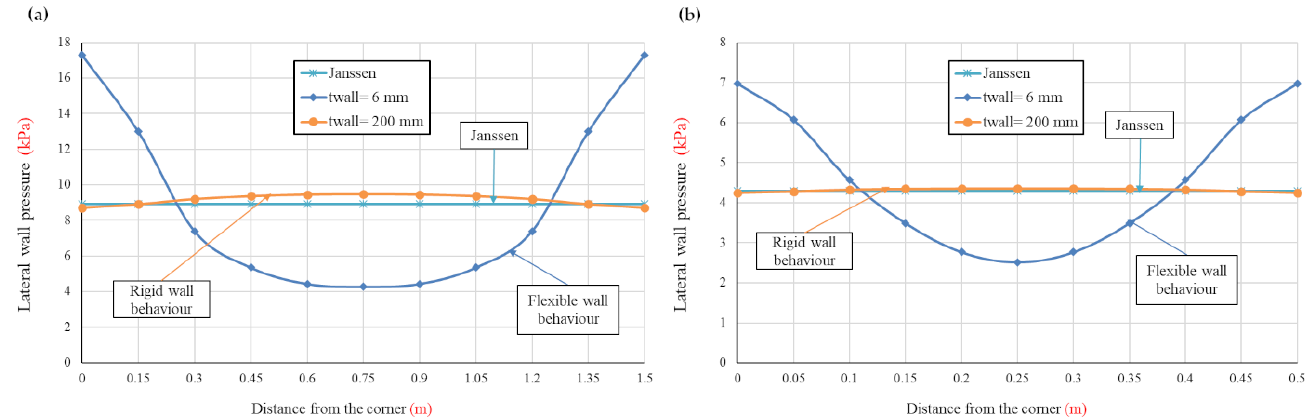
Figure 18. Lateral wall pressure comparison between rigid and flexible walls, as well as Janssen. ( a ) Flat model silo 1.5 × 1.5 × 2.5 m; ( b ) slender model silo 0.5 × 0.5 × 2.5 m.